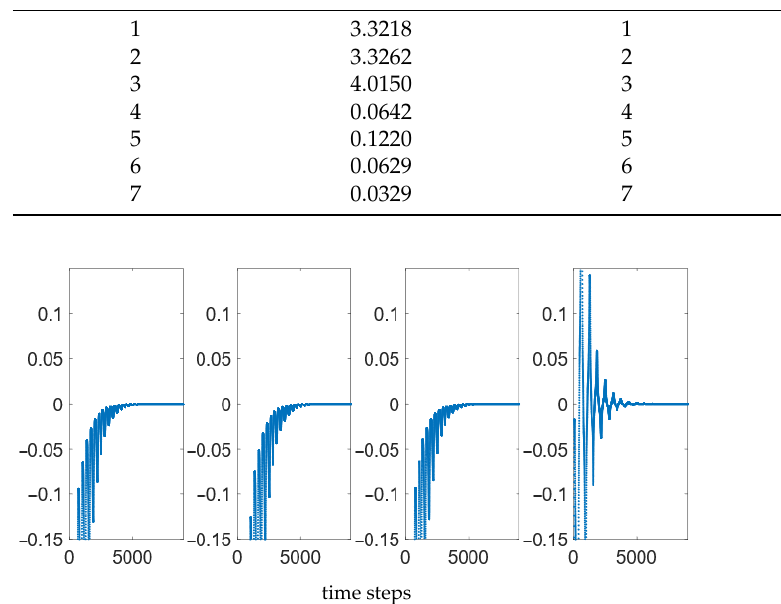
Figure 8. Error of x calculated over time for methods 4–7, in order. Note that the error curve of method 7, normalized gradient least mean squares, is distinct from the others. MAE is used in as- sessing model performance to handle both positive and negative error swings. Method 4, feedforward using the drive-response methodology in [10], successfully forced the responder oscillator to follow the target trajectory. Methods 5 – 7 built upon method 4, adding deterministic artificial intelligence feedback as described in [16] to esti- mate and learn the system parameters.